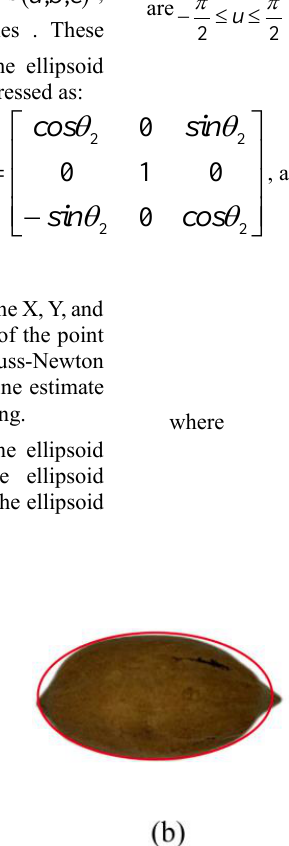
Figure 5. Different types of nut shapes and the ellipse (Red). (a) Walnut; (b) Pecan; (c) Macadamia